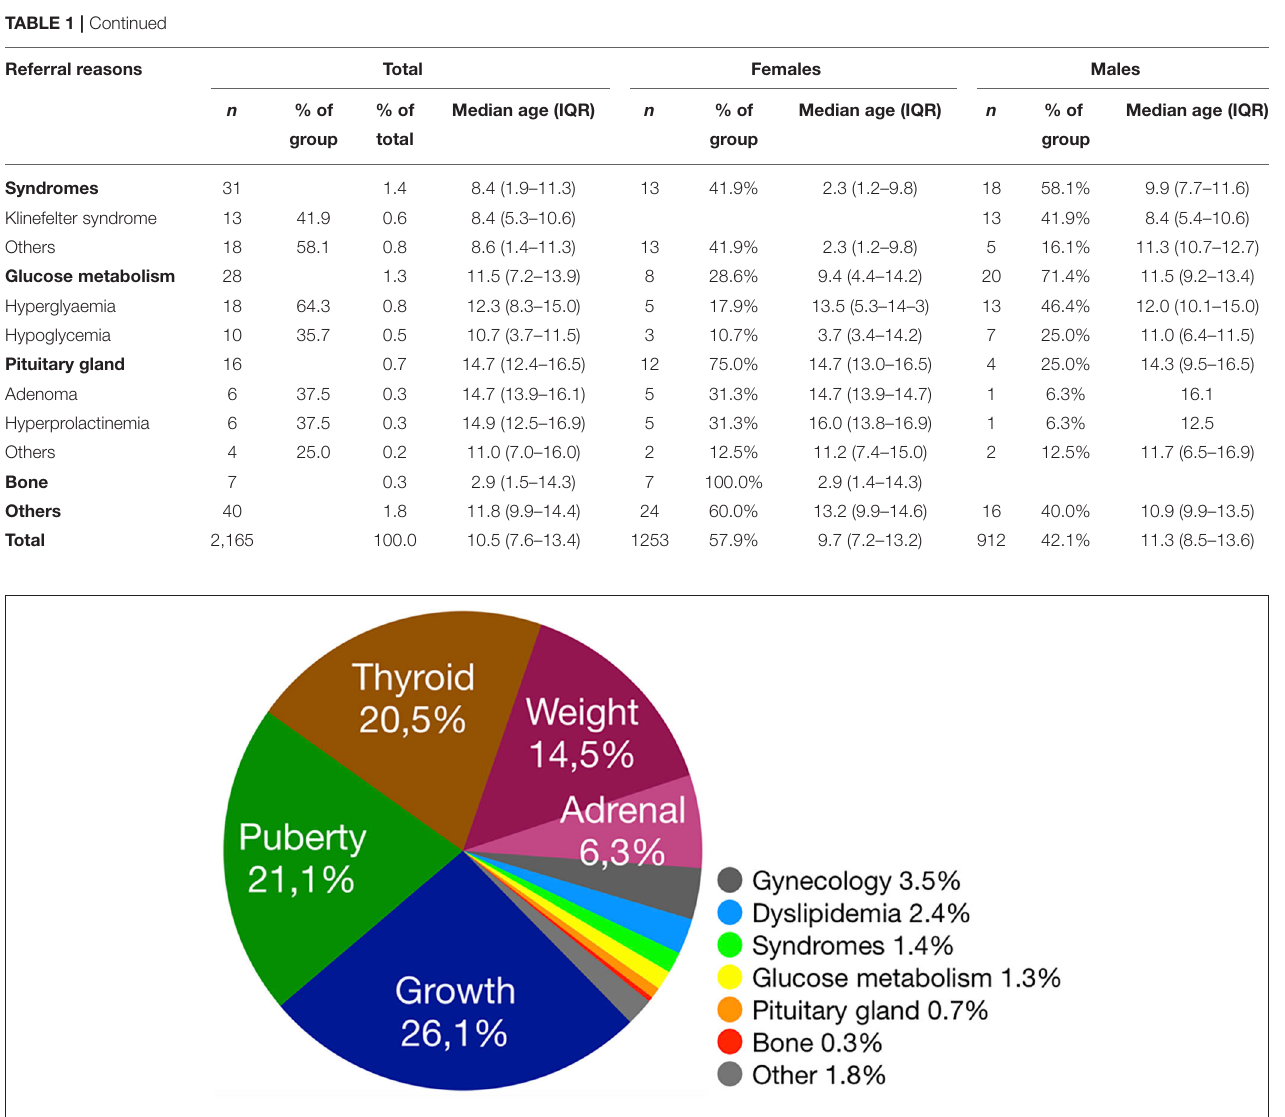
FIGURE 1 | Distribution of referral reasons per main cumulative groups.